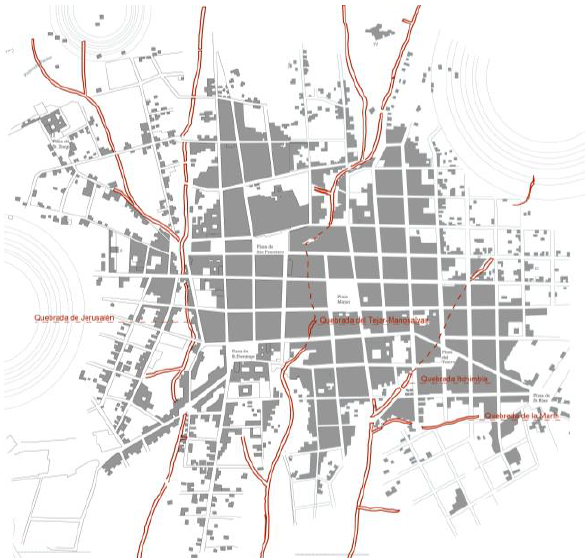
Figure 3. Quito’s ravine in relation with the ancient urban fabric of the historical city centre. Credits: Paola